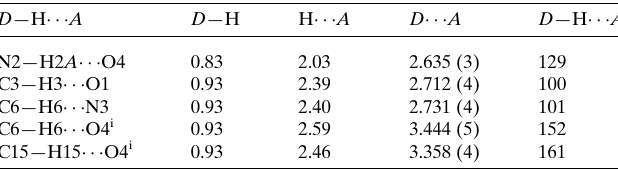
Table 1 Hydrogen-bond geometry (A˚ , (cid:2) ).